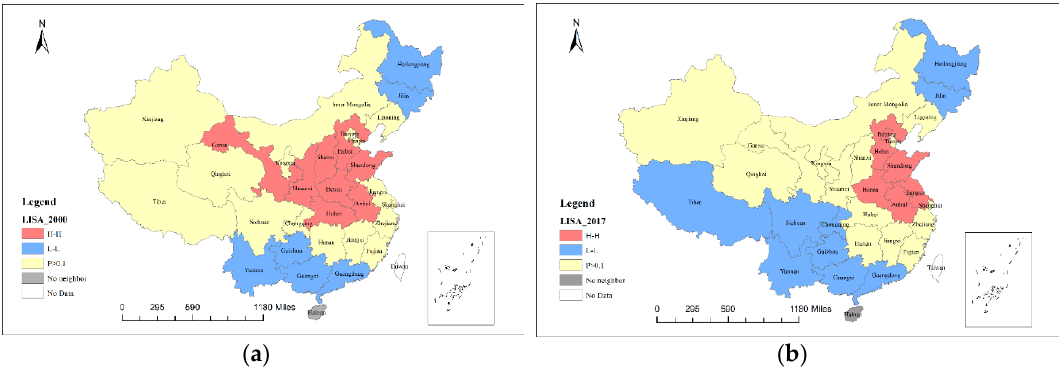
Figure 3. LISA agglomeration maps of China’s smog pollution. ( a ) Beginning of the investigation period; ( b ) End of the investigation period.